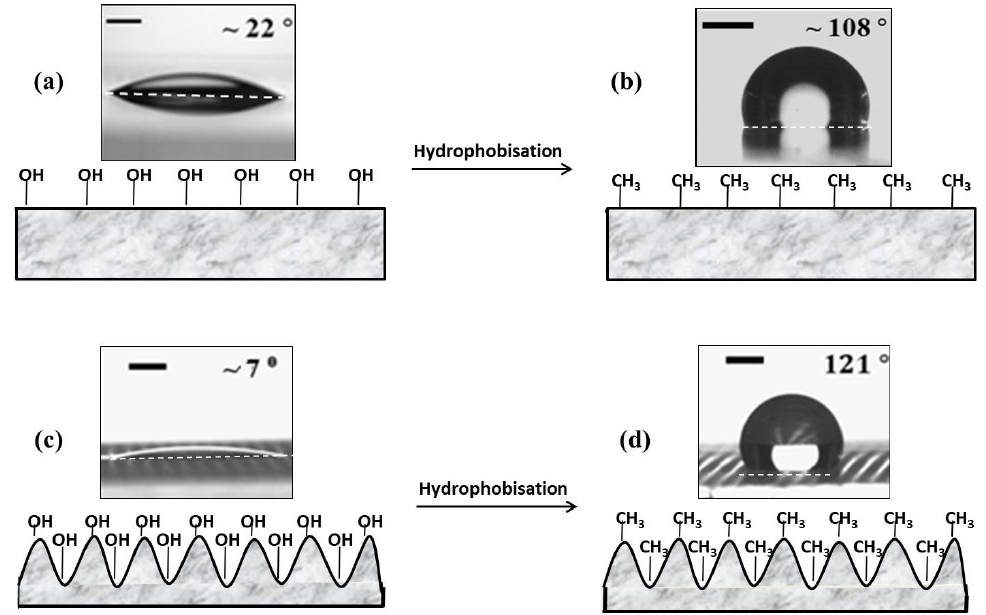
Figure 4. DSA images showing the configuration of water drops on smooth glass slides in air before hydrophobisation ( a ) and at maximum hydrophobisation ( b ); configuration of water drops on rough glass slides in air before hydrophobisation ( c ) and at maximum hydrophobisation ( d ). Under each image, the hypothetical distribution of reactive components of the respective surfaces is